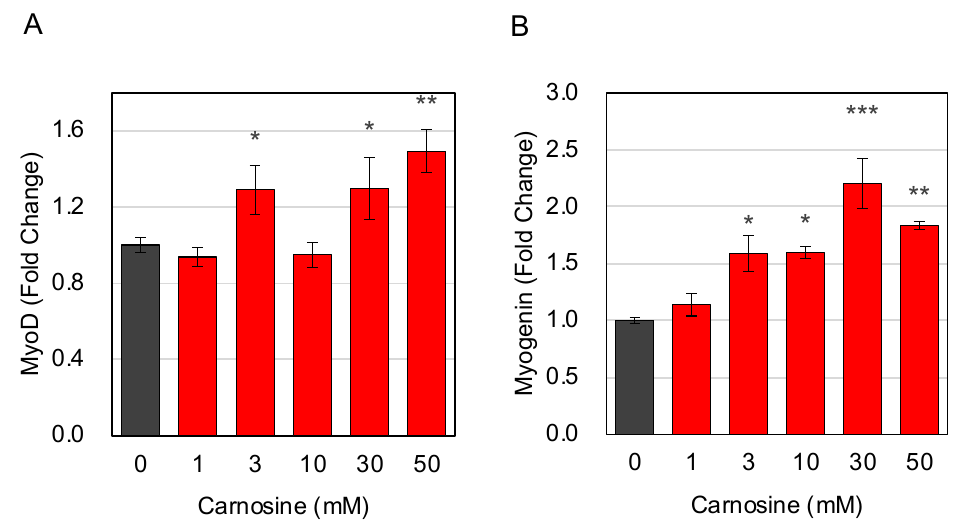
Figure 1. Expression of differentiation marker gene. C2C12 cells were differentiated in the presence of indicated amount of carnosine. Expression of muscle differentiation marker genes of MyoD ( A ) and Myogenin ( B ) was quantitatively determined by RT-qPCR. Multiple comparisons between groups were performed using one-way ANOVA with Tukey’s post-hoc test. Statistical significance was defined as p < 0.05 when compared to control (* p < 0.05; ** p < 0.01; *** p < 0.001).